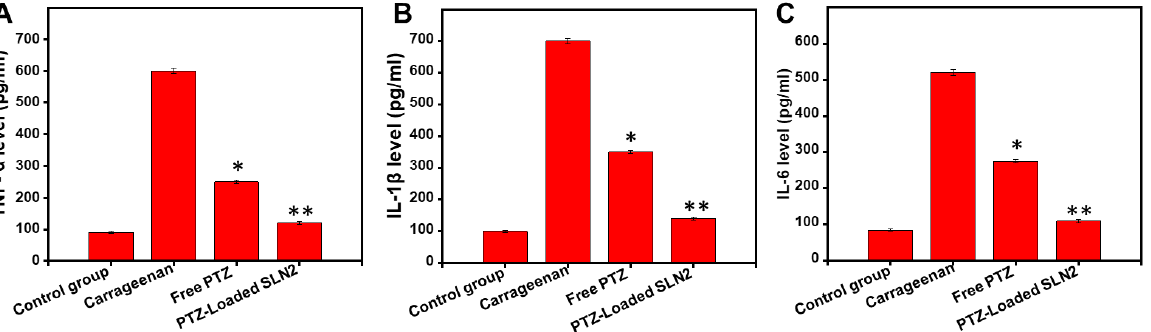
Figure 9. Effects of PTZ-SLN2 on the inflammatory cytokines in paw tissue of Wistar rats (N = 20 rats, n = 5/group) following carrageenan-induced inflammatory pain. The samples were analyzed by ELISA at the time point of 6 h after treatment. ( A ) Impact on TNF- α concentration (pg/mL); ( B ) Impact on IL-1 β concentration (pg/mL); ( C ) Impact on IL-6 concentration (pg/mL). Control group 1 (1 × PBS, orally administrated), carrageenan group 2 (200 μL/paw of the 1% w / v solution, single injection), free PTZ group 3 (carrageenan 200 μL/ paw of the 1% w / v solution + free PTZ orally administrated at 5 mg/kg), and PTZ- loaded SLN2 group 4 (carrageenan 200 μL/paw of the 1% w / v solution + PTZ-loaded SLN2, orally administrated at 5 mg/kg). The carrageenan was administered 30 min into the Groups 3 and 4 before the treatment (with free PTZ and PTZ-loaded SLN2, respectively). The carrageenan group strongly increased the tested pro-inflammatory cytokines, compared to that of the (vehicle) control group. These effects were all significantly reduced in the free PTZ group and, to a better extent, PTZ-loaded SLN2 group. Data are expressed as mean ± SD ( n = 3). * p < 0.05 and ** p < 0.01 represent mild and moderate statistical significance, respectively, when compared to the carrageenan group.